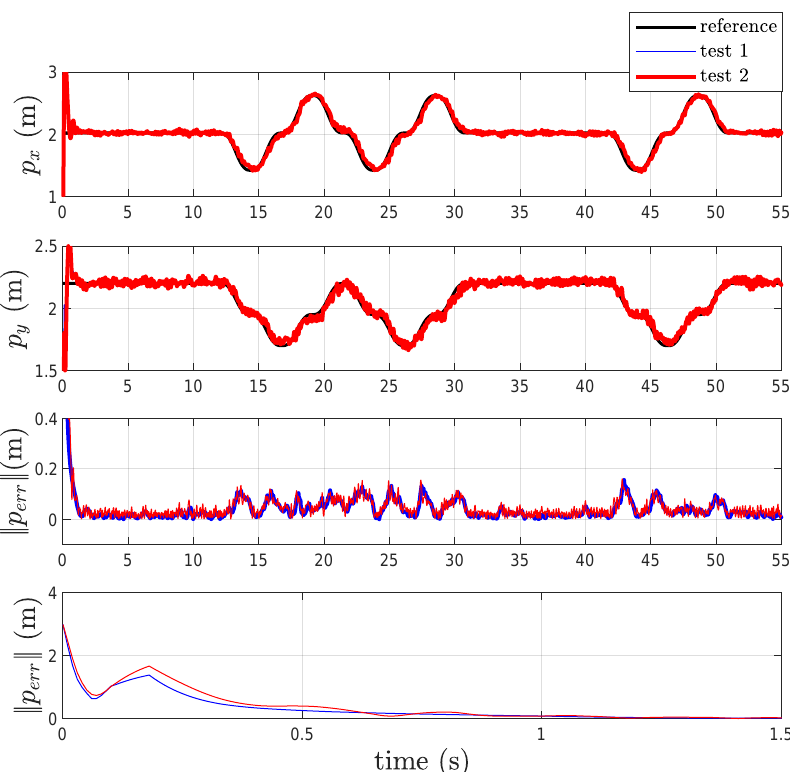
Figure 3. References, estimated coordinates of P , and corresponding norm-2 error (cid:107) P err (cid:107) in Test 1 and Test 2 .